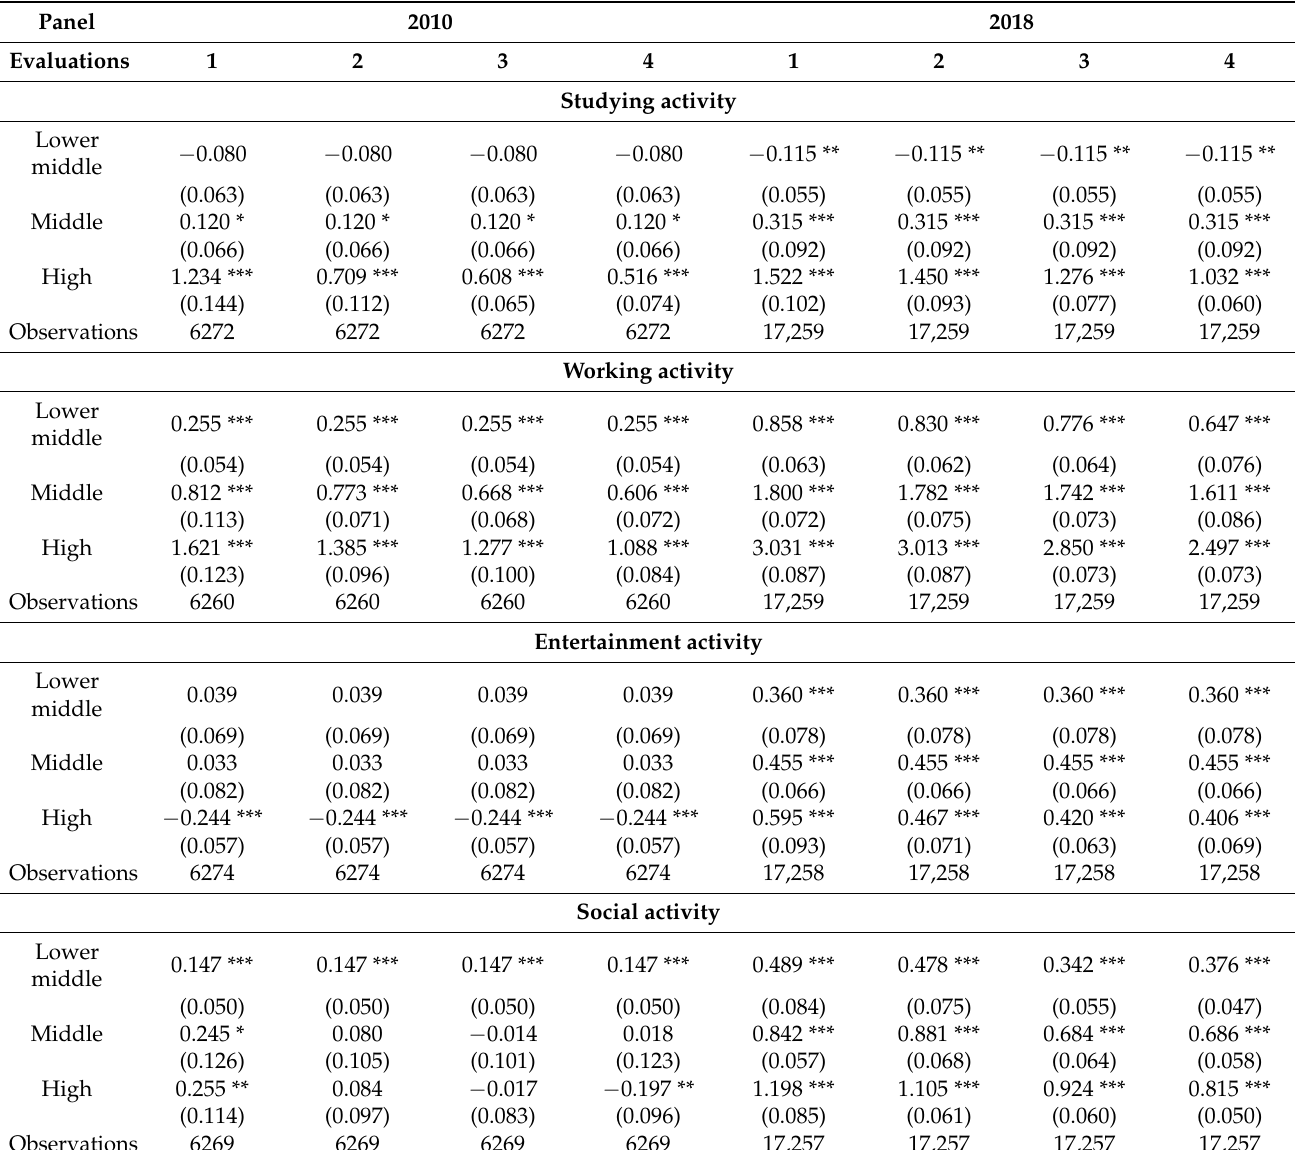
Table 3. Partial results from the generalised partial proportional odds model of the ISEI scores predicting the importance of online activities in the 2010 and 2018 panels (robustness